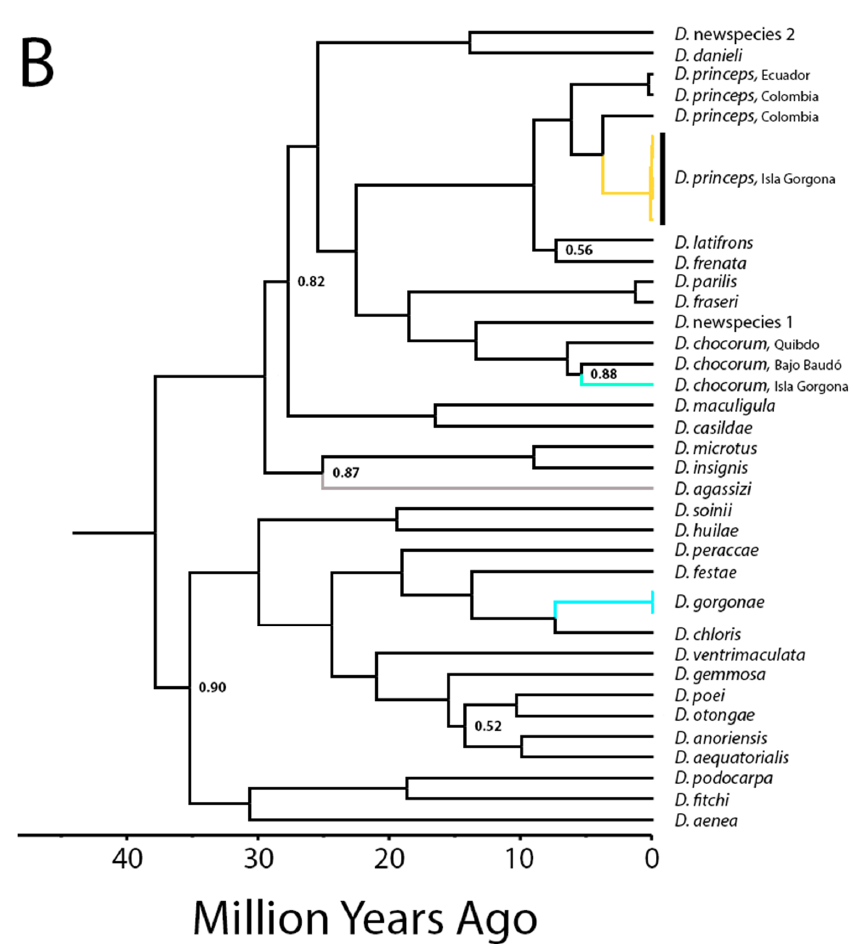
Figure 4. Bayesian reconstruction of Dactyloa and Norops anoles dated using a combination of fossil calibrations and a mtDNA mutation rate. All lineages of Pacific Island anoles are colored, and posterior values are present on all nodes with <0.95 probability. (A) Norops clades pertinent to this study. (B) Dactyloa clades pertinent to this study. Table 1. Mean dates and 95% confidence intervals for select nodes relevant to Pacific Island anoles, using multiple dating methods (fossil-fossil calibrations + mutation rate; rate = mutation rate alone). Node Fossil 95% Rate 95% Dactyloa agassizi + Dactyloa insignis / Dactyloa microtus